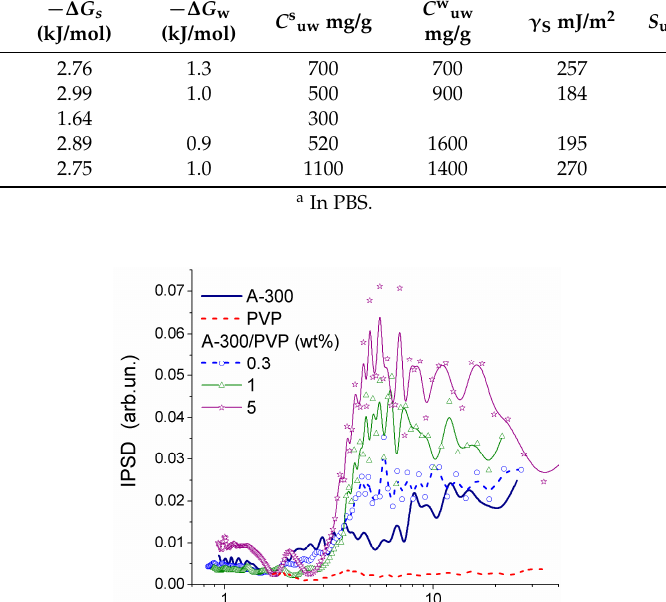
Figure 18. ( a , c , e ) Relationships between the amounts of unfrozen water and changes in the Gibbs free energy and ( b , d , f ) the corresponding PSD (NMR cryoporometry with GT equation at k GT = 67 K nm) for ( a , b ) MCC, ( c , d ) MCC/A-300 (5.6:1), and MCC/TiO 2 (3:1) (adapted from [13]). Table 6. Parameters of interfacial water for pure silica and silica/PVP suspensions ( C SiO2 = 6 wt %). System